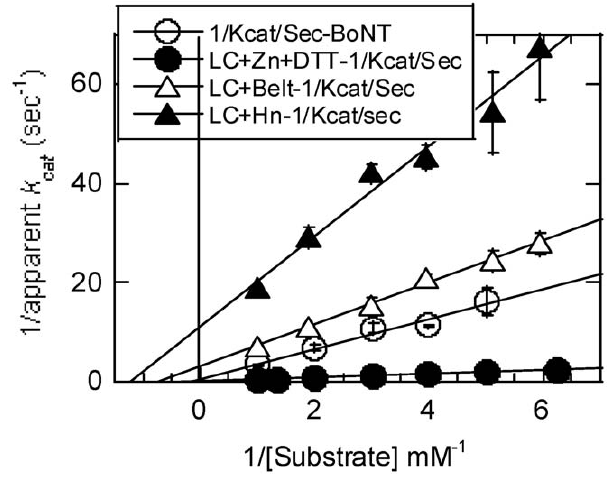
Figure 6. Time course of reactions catalyzed by LC and LC + Hn. LC (0.4 m g, closed circle) or LC + Hn (1.8 m g, closed triangle) and 1 mM peptide substrate in a 30 m l of reaction mixture containing ZnCl 2 and DTT was incubated at 37 u C. At the indicated times, products in two vials was analyzed by HPLC as described in the EXPERIMENTAL PROCE- DURES. PLoS ONE |